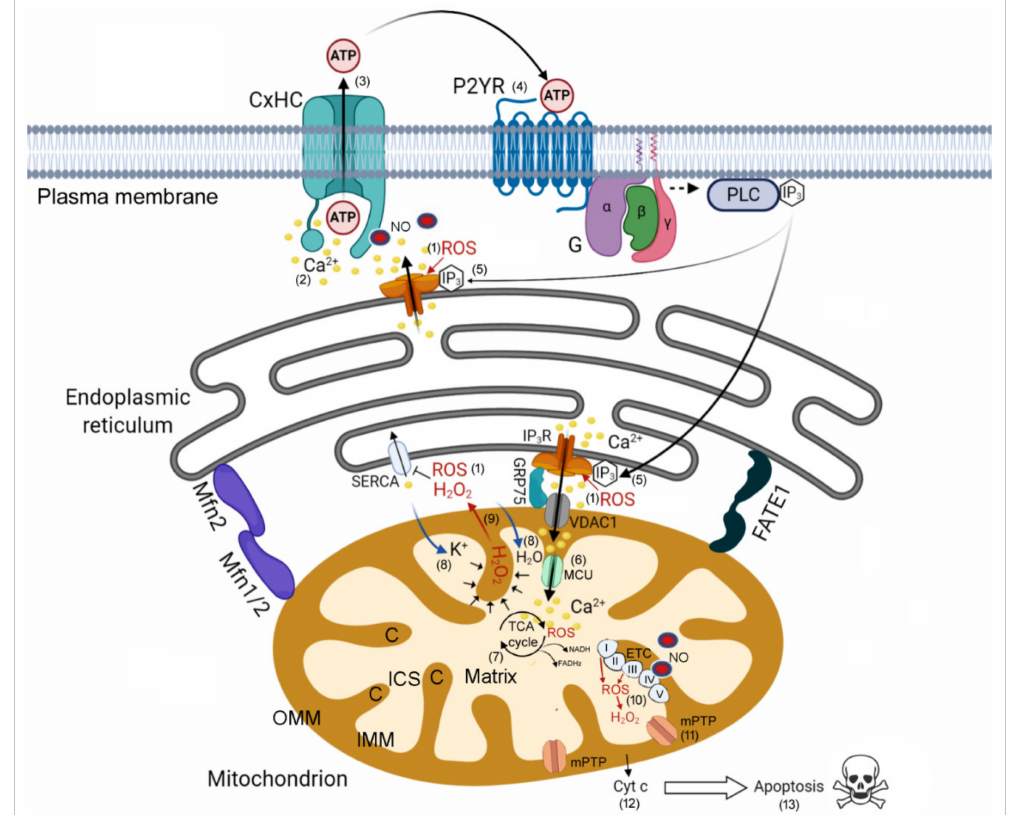
Figure 7. Schematic model for connexin (Cx) hemichannels (HC)-related signaling downstream of photosensitizer (PS) activation. (1) Reactive oxygen species (ROS), generated directly or indirectly after PS photoactivation [22], activate inositol 1,4,5-trisphosphate (IP 3 ) receptors (Rs), promoting calcium (Ca 2+ ) release from the endoplasmic reticulum (ER). (2) The rise in cytosolic Ca 2+ concentration gates HCs from the inside, (3) permitting the release of adenosine triphosphate (ATP) from cytosol to extracellular milieu. (4) The released ATP activates metabotropic P2YRs and consequent IP 3 production via G-protein-coupled activation of phospholipase C (PLC). (5) IP 3 binding to IP 3 R in the ER potentiates ROS-mediated Ca 2+ release. (6) This enhances Ca 2+ uptake into the mitochondrial matrix via voltage-dependent anion-selective channel 1 (VDAC1) in the outer mitochondrial membrane (OMM) and mitochondrial Ca 2+ uniporter (MCU) in the inner mitochondrial membrane (IMM). The tight spacing between ER and mitochondria, which is key for efficient ER-mitochondria Ca 2+ transfer, is regulated by mitofusin (Mfn) proteins and fetal and adult testis-expressed 1 (FATE1). (7) Within the matrix, Ca 2+ regulates the tricarboxylic acid (TCA) cycle by controlling the activity of three dehydrogenases, promoting increased synthesis of nicotinamide adenine dinucleotide (NADH) and flavin adenine dinucleotide (FADH 2 ) and consequent augmented ATP production by complex V (ATP synthase) of the electron transport chain (ETC). (8) Ca 2+ entry also drives potassium (K + ) and water (H 2 O) influx into the matrix. (9) The increased internal pressure squeezes hydrogen peroxide (H 2 O 2 ) out of mitochondrial cristae (C), reinforcing ROS-mediated opening of the IP 3 R and blockade of the Sarco-Endoplasmic Reticulum Ca 2+ ATPase (SERCA) pump, which leads to irreversible ER emptying. (10) Ca 2+ overload of the mitochondrial matrix enhances ROS levels and H 2 O 2 mainly via complex I and III in the ETC, promoting mitochondrial permeability transition pore (mPTP) opening. (11) Prolonged opening of the mPTP causes depolarization of the IMM and swelling of the mitochondrial matrix, which ensues in the rupture of the OMM. (12) Consequently, cytochrome c (Cyt c) is released, thus promoting apoptotic cell death (13). ICS, intracristal space (see [57,58,60–68]). These events are exacerbated by nitric oxide (NO), a key diffusible byproduct of aluminum phthalocyanine chloride photoactivation in irradiated cells [20].